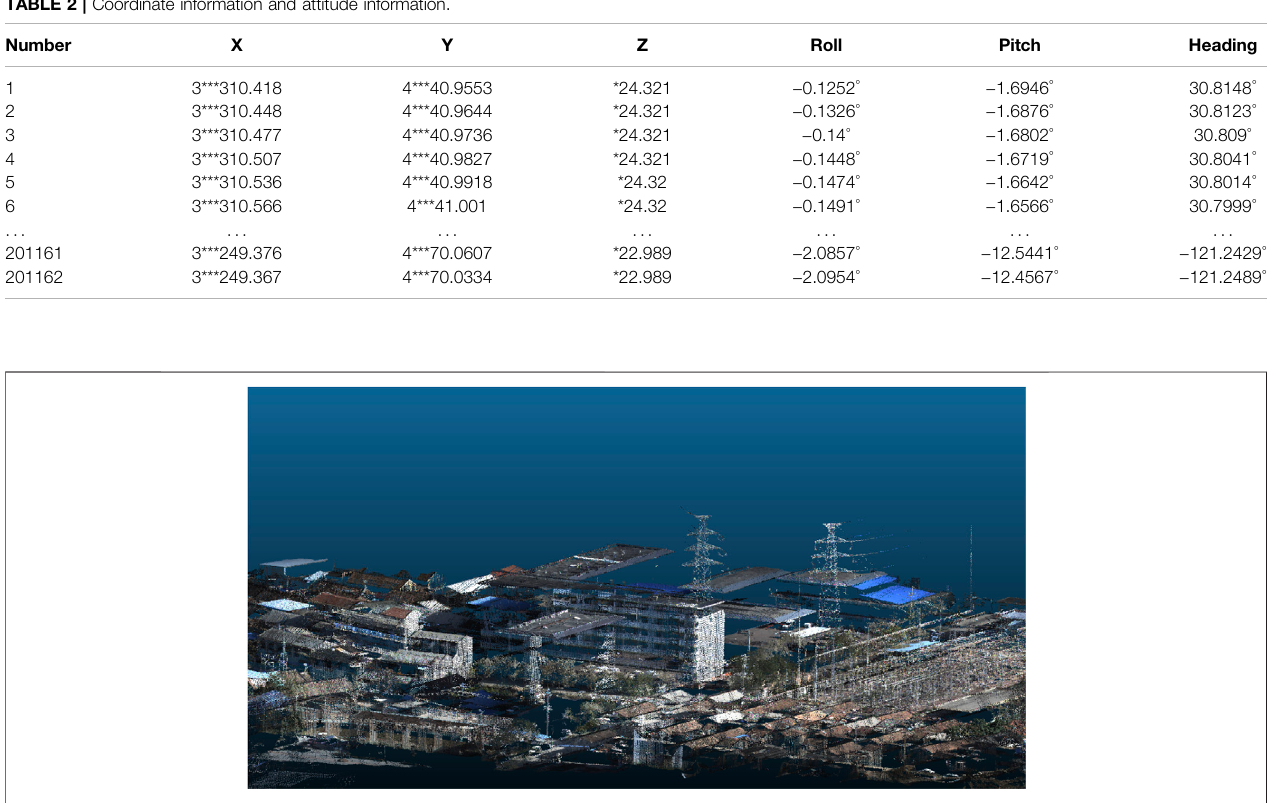
FIGURE 4 | True-color point cloud.